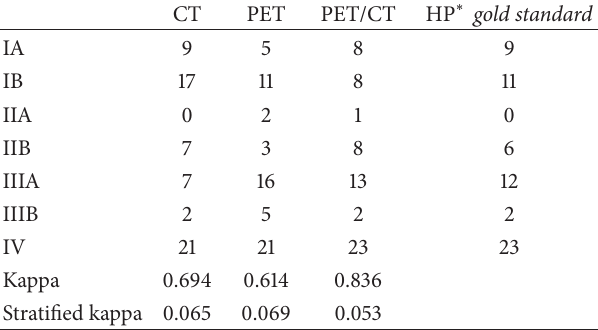
Table 2: Concordance between the three diagnostic techniques and TNM staging ( 𝑛 = 63 ; 40 surgical patients and 23 with metastases). CT